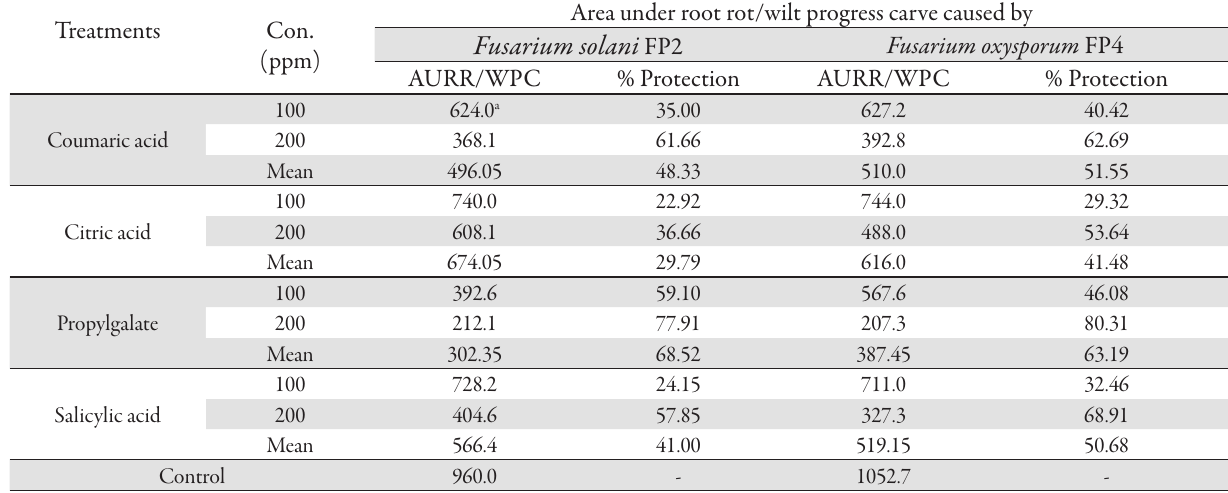
Tab. 5. Effect of paper seedling soaking in antioxidant solutions on area under root rot/wilt progress curve caused by Fusarium solani isolate FP2 and Fusarium oxysporum isolate FP4 in pots Treatments